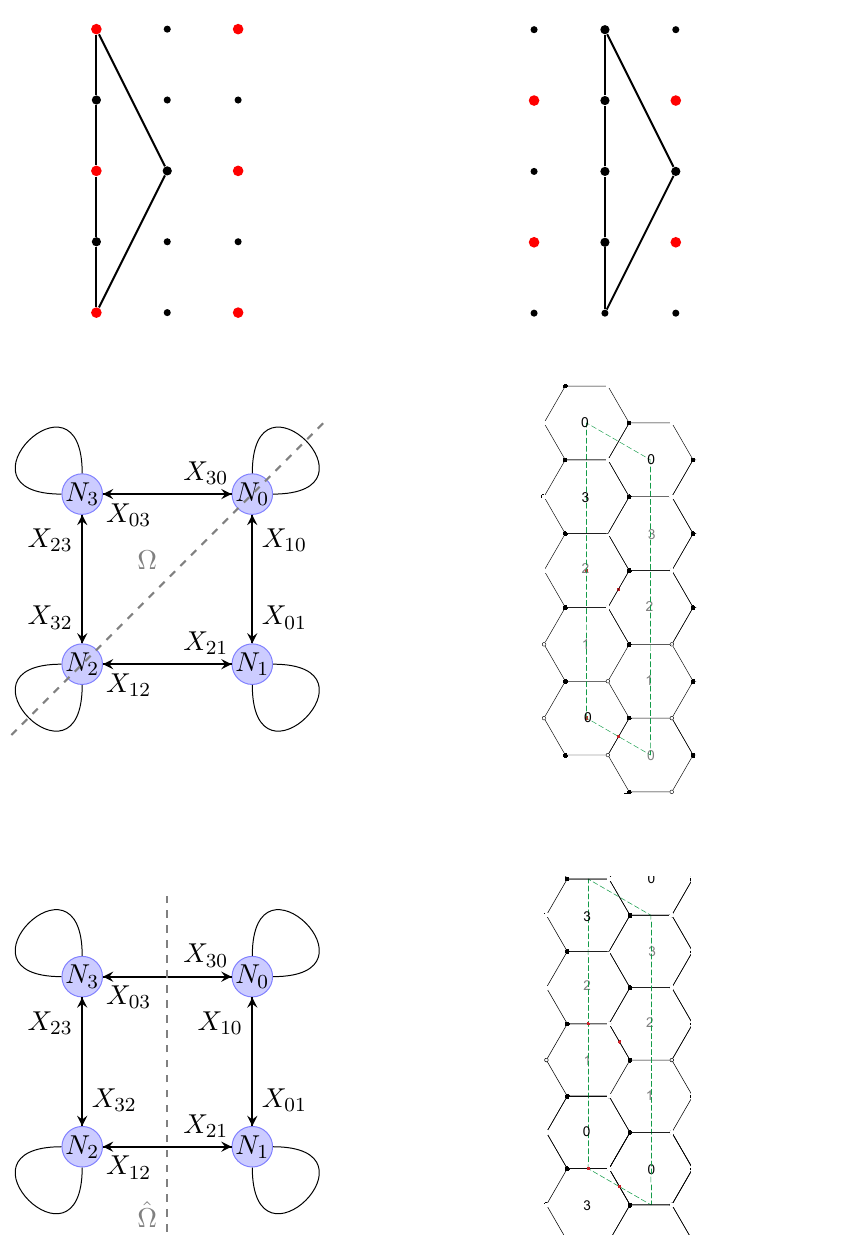
. The upper (cid:12)gure shows the toric 4